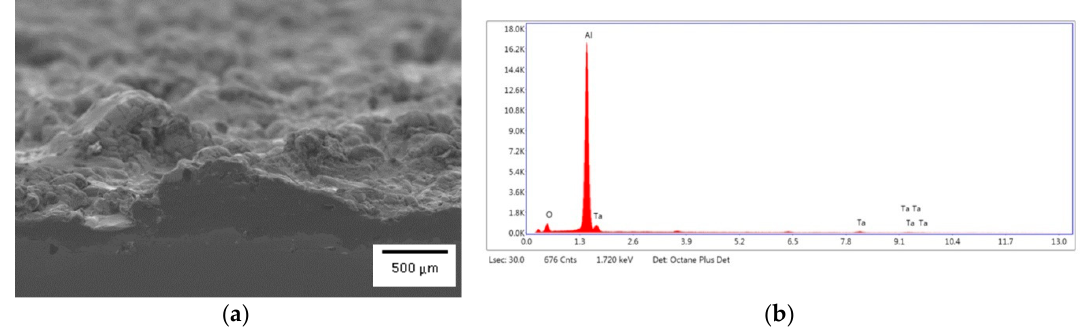
Figure 5. Ta (400 μ m)/Al (100 μ m)/SS test piece: ( a ) surface characteristics of residual Al layer; ( b ) EDX analysis of Al–Ta–O compound layer.